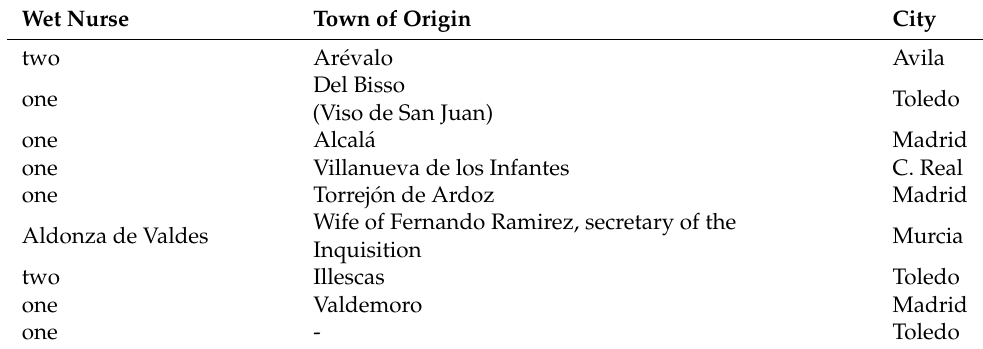
Table 2. Origin of wet nurses rejected by doctors of the royal